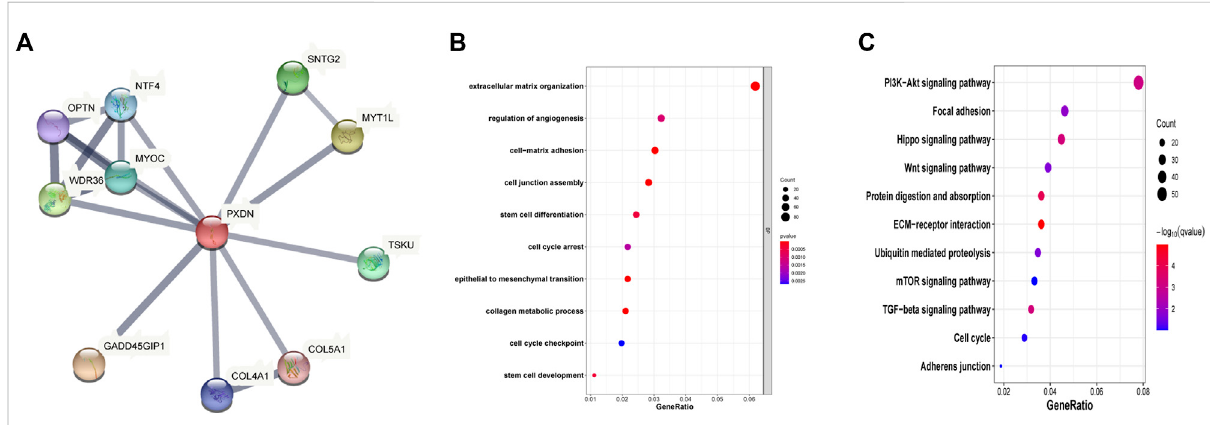
FIGURE 3 Function analysis of PXDN. (A) Construction of PXDN associated PPI network. (B) GO biological analysis (C) KEGG pathway